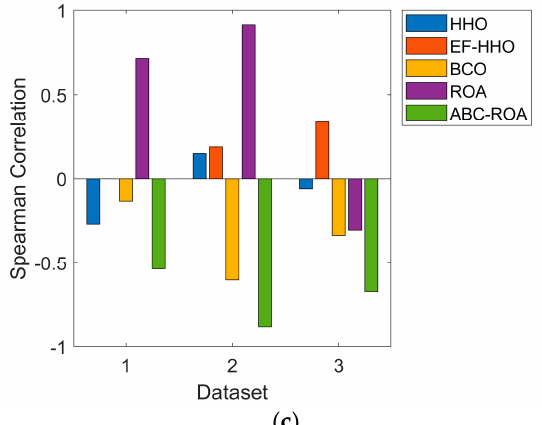
Figure 6. Effectiveness analysis of the developed blockchain-based privacy preservation system to ( a ) Euclidean distance, ( b ) Pearson correlation and ( c ) Spearman correlation.